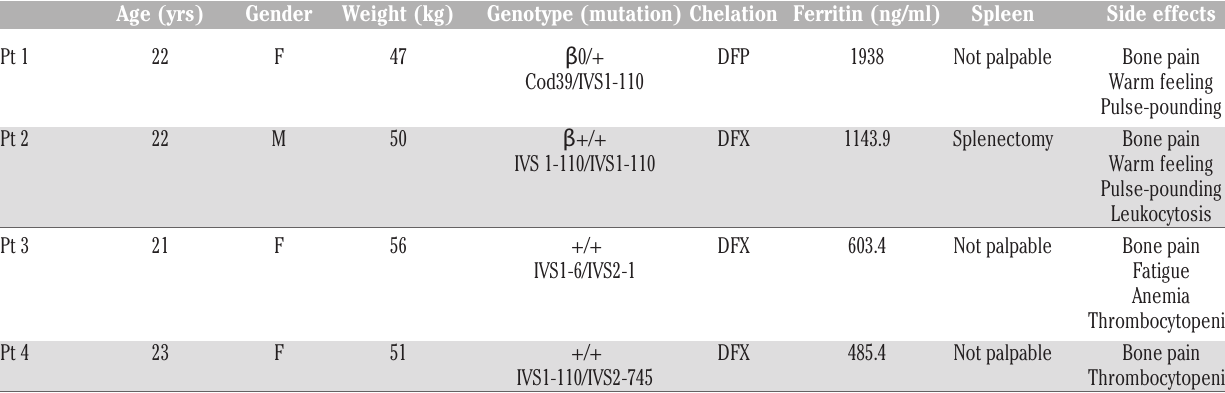
Table 2. Patient characteristics and side effects during